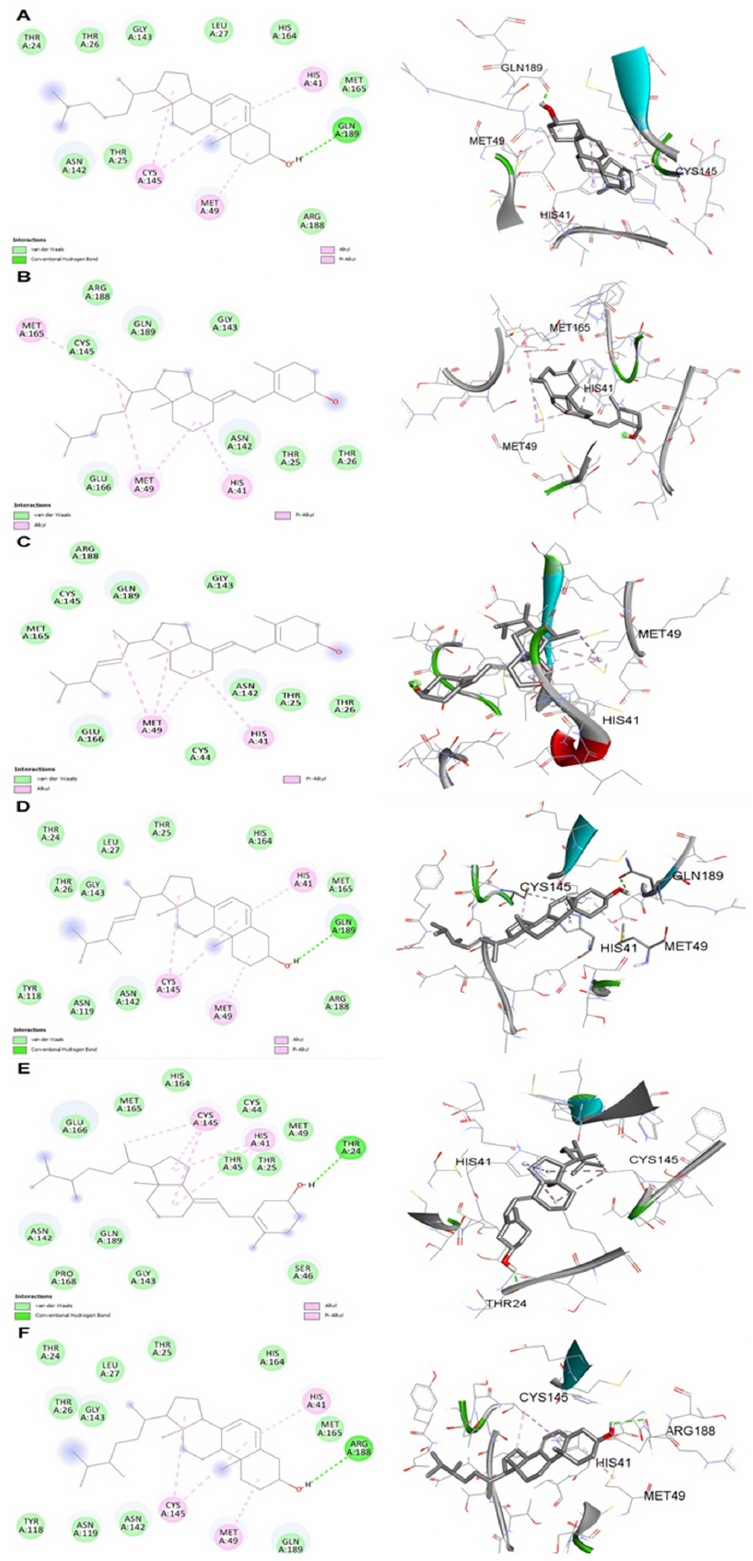
1 Figure 1. Molecular docking 2D and 3D interaction representation between SARS-2 Mpro and ( A ) 7-dehydrocholesterol, ( B ) cholecalciferol, ( C ) ergocalciferol, ( D ) ergosterol, ( E ) 22,23-dihydroergocalciferol, and ( F )